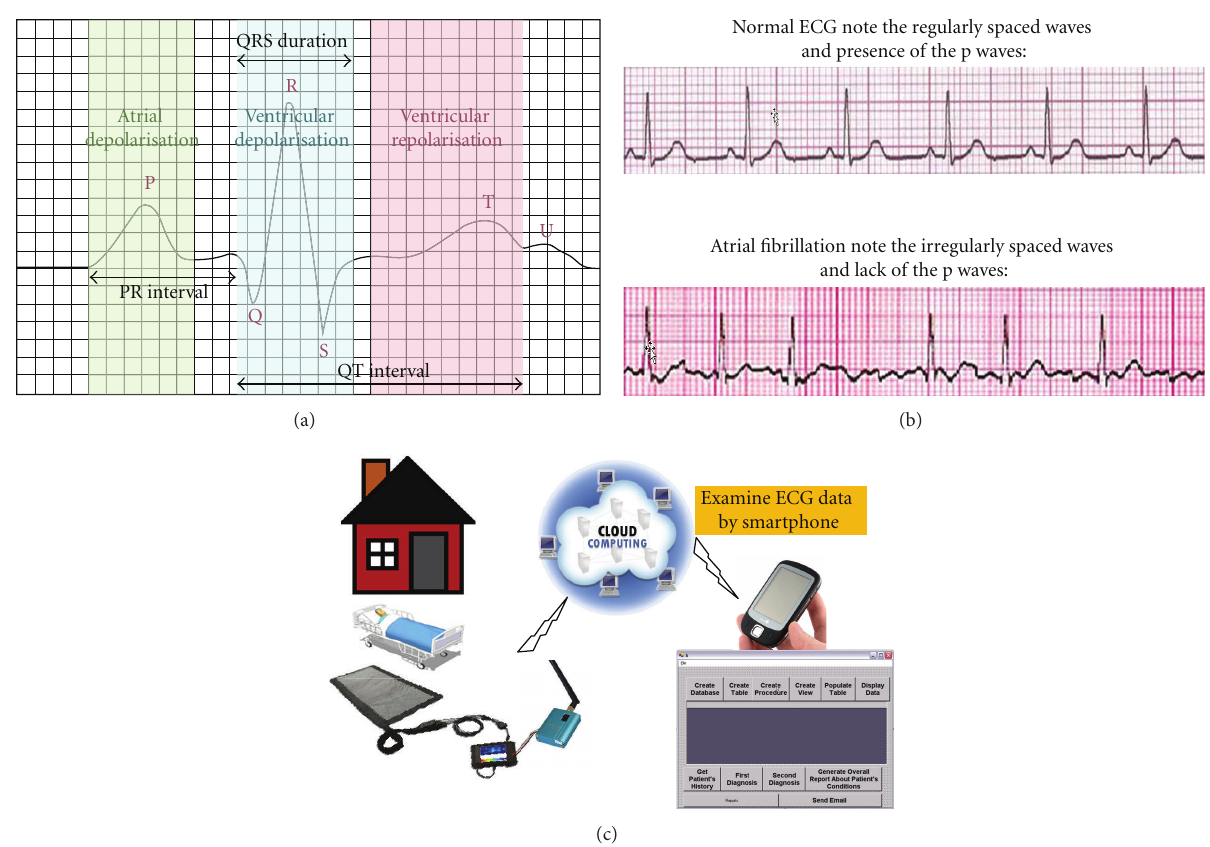
Figure 4: (a) Shows the healthy ECG waveform, (b) abnormal heart beats are exemplified, (c) affordable air mattress ECG home monitoring